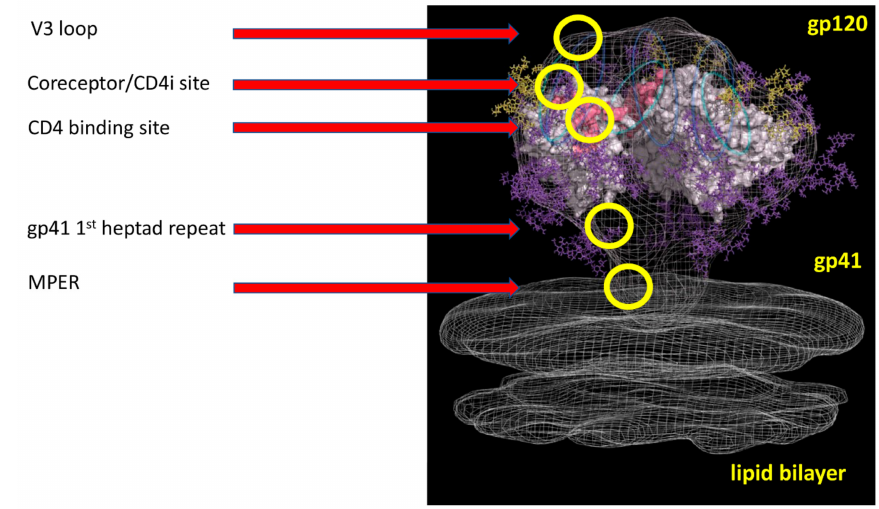
Figure 2. Schematic diagram of the HIV-1 trimeric envelope glycoprotein complex showing the approximate locations of domains in yellow circles that are recognized by the broadly neutralizing nanobodies listed in Table 1.